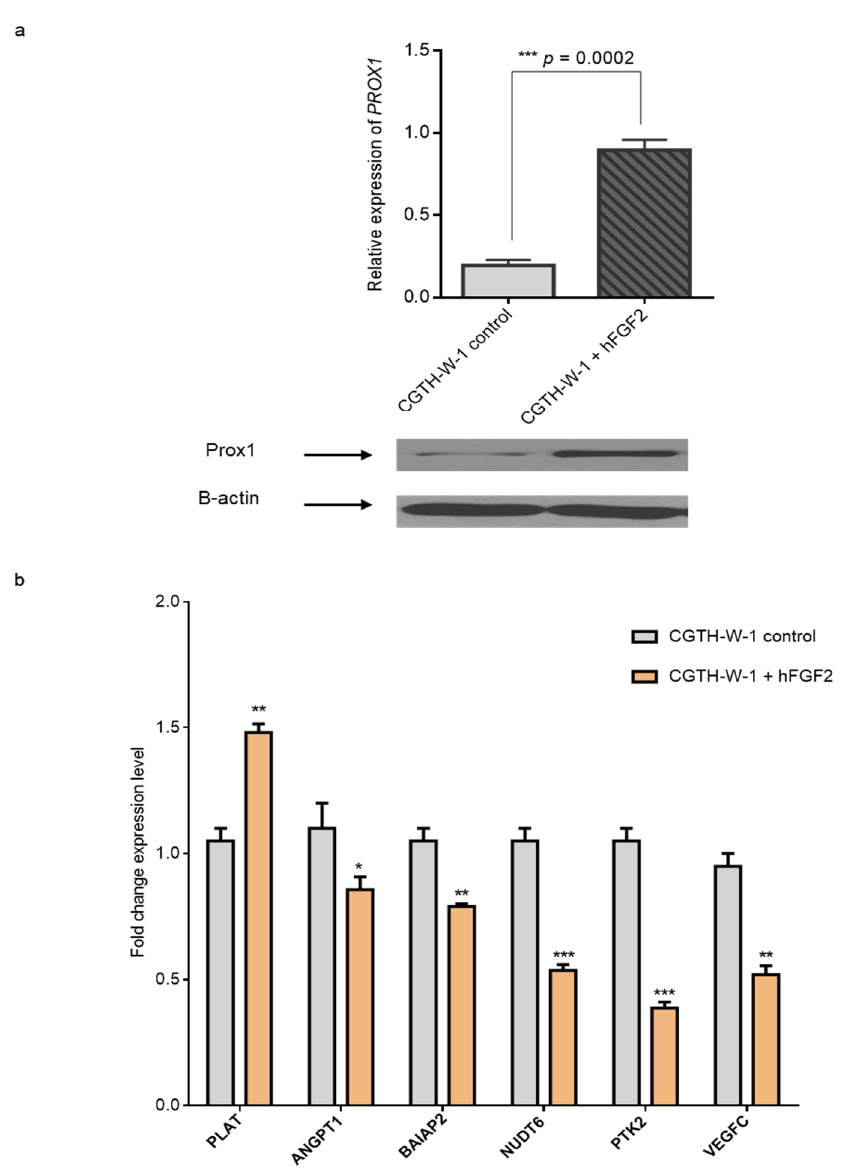
Figure 5. FGF2 induces of PROX1 overexpression in CGTH-W-1 cells. ( a ) Treatment with FGF2 resulted in 4-fold upregulation of PROX1 mRNA compared to control treated with 0.01% DMSO in RT-qPCR analysis. PROX1 protein overexpression in CGTH-W-1 cells cultured with FGF2 was detected using Western blotting with anti-PROX1 antibody; β -actin served as an internal control. Signals of WB were measured using ImageJ and the final relative quantification values show ~4 × higher intensity of PROX1 band after FGF2 treatment in comparison to control. ( b ) Gene expression after FGF2 treatment analyzed by RT-qPCR.